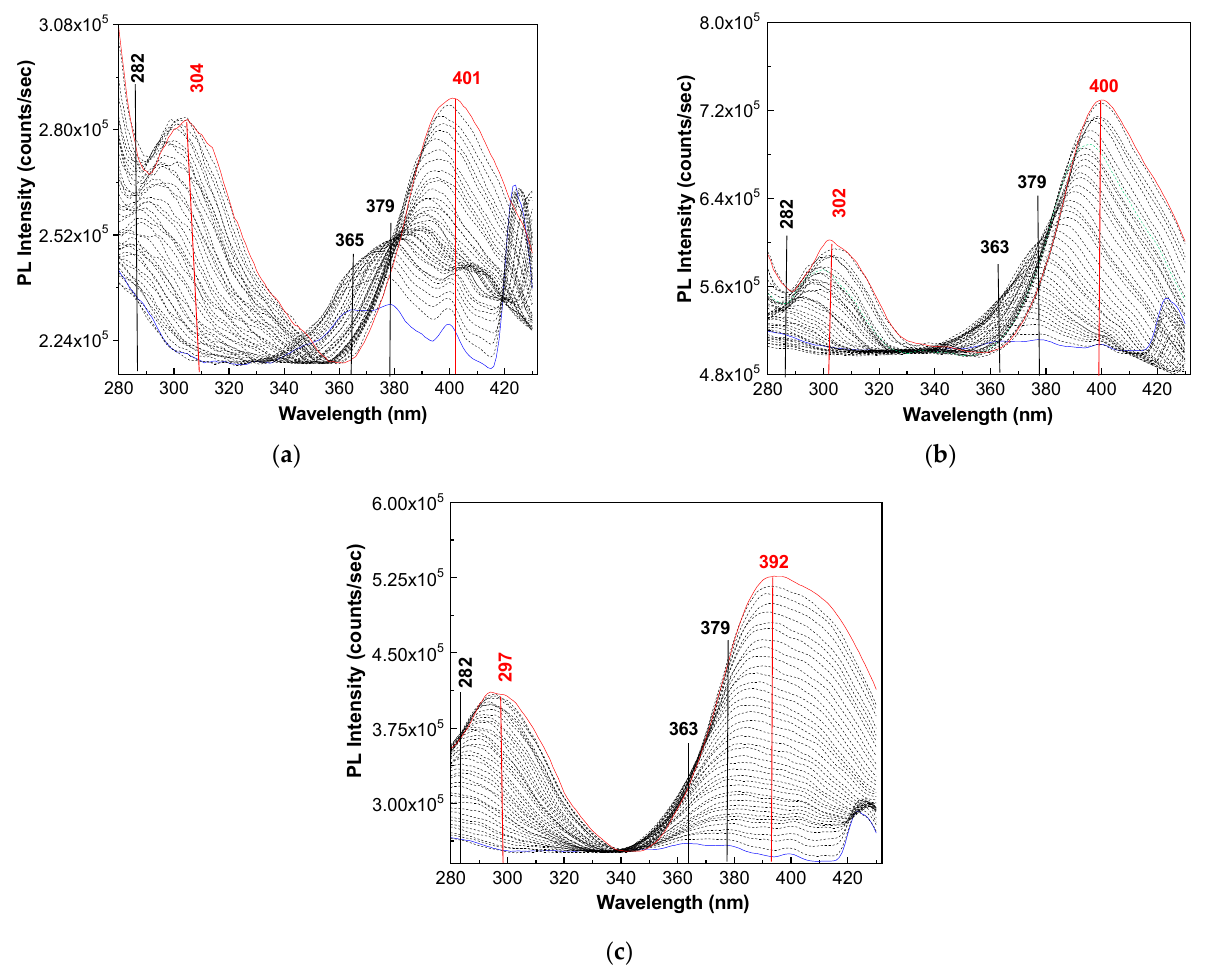
Figure 2. PLE spectra of the AZA:ST samples, with ST concentrations in the reaction mixture equal to 75 wt.% ( a ), 50 wt.% ( b ) and 25 wt.% ( c ), recorded when the emission wavelength ( λ em ) was equal to 450 nm. Blue and red curves indicate the PLE spectra of samples in dark conditions and after 360 min of UV irradiation. Black curves correspond to PLE spectra collected each after 108 s of UV irradiation.